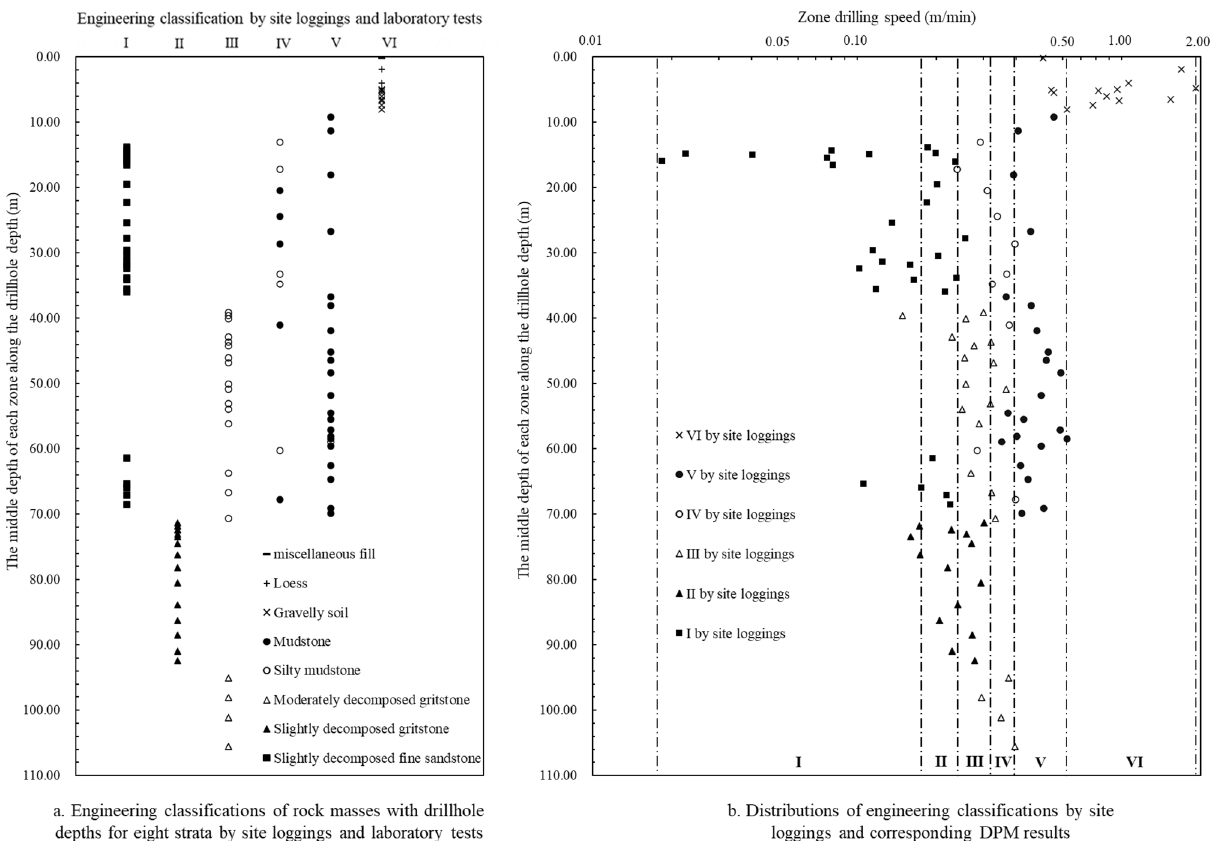
Figure 15. Comparison between engineering classification grades determined by digitalization data and manual loggings along the drillhole.